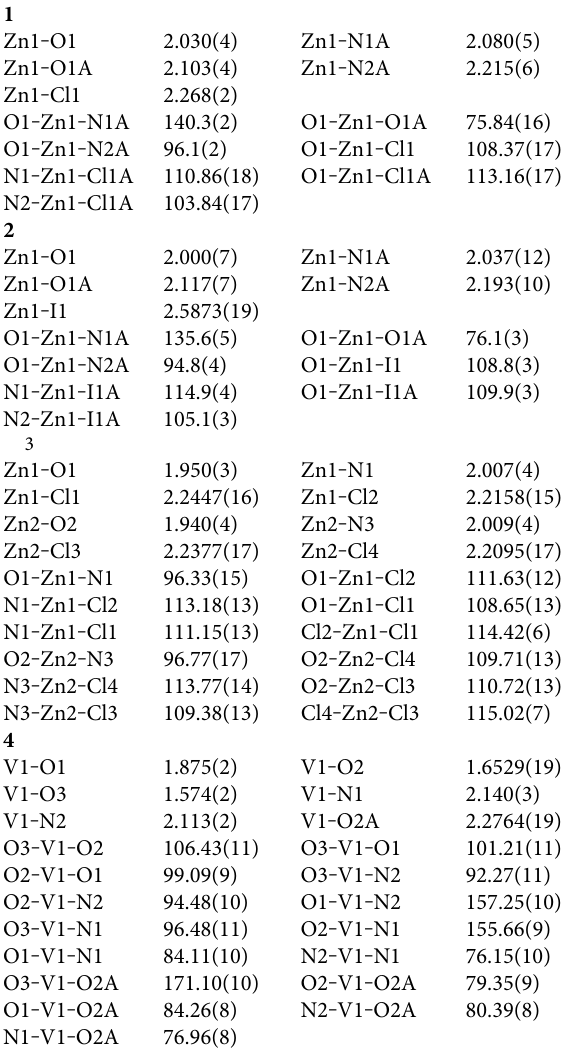
Table 2. Selected bond distances (Å) and angles (°) for the